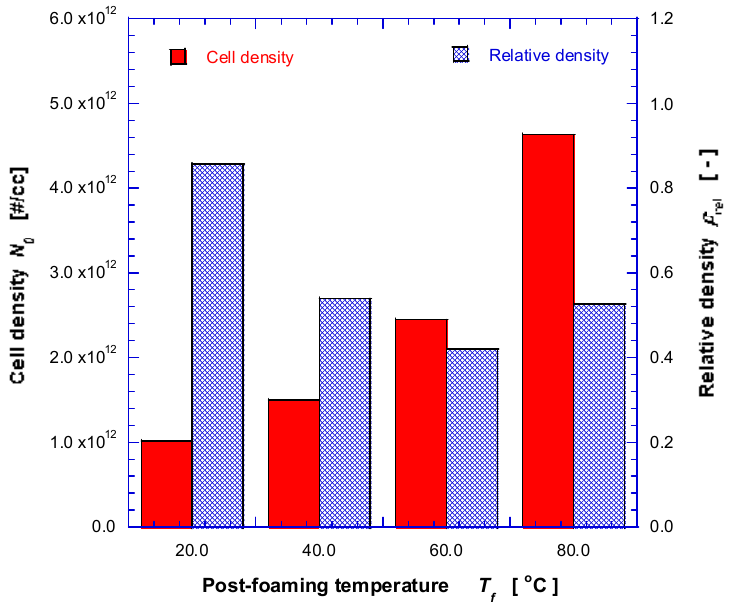
Figure 5. Effect of post-foaming temperature on cell (pore) density and relative density measured from SEM cross-section images (e.g., Figure 2).